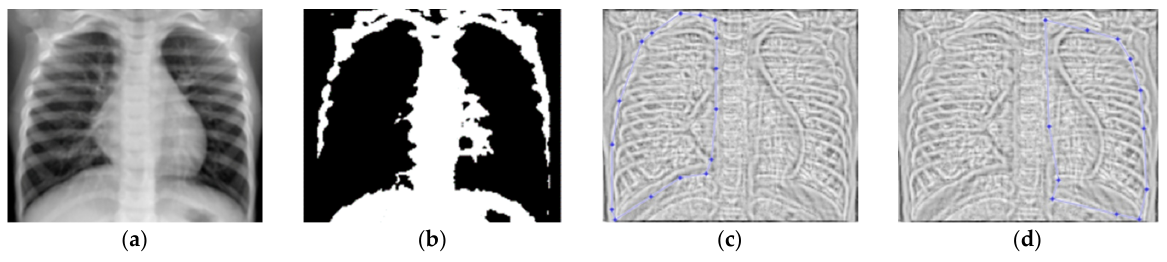
Figure 29. ( a ) Healthy lung image, ( b ) binary version, ( c ) mask for the left lung, ( d ) mask for the right lung.